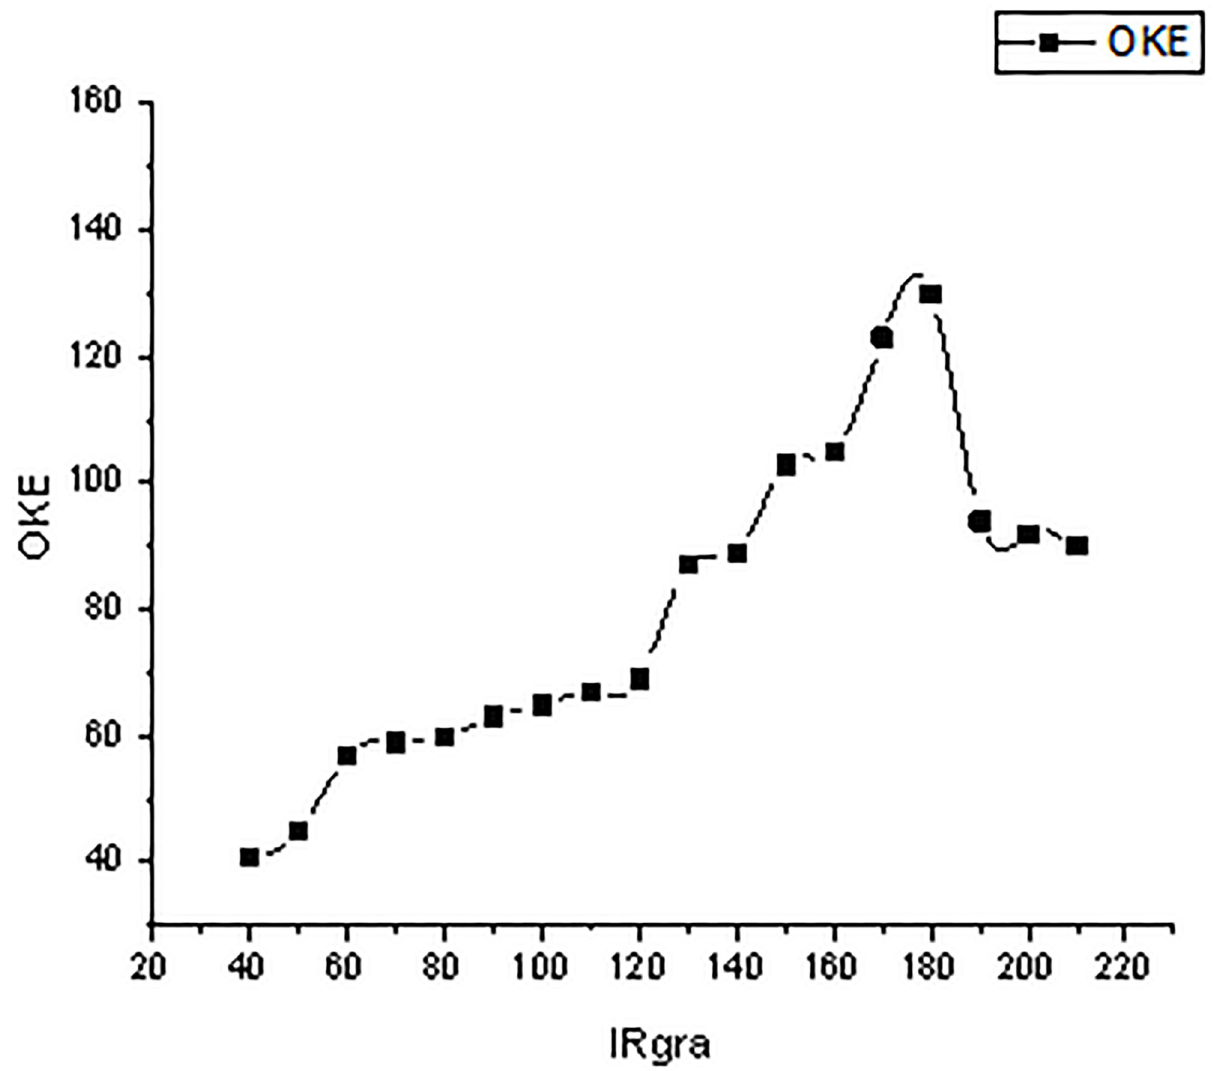
Fig 3. The old dynamic energy change whit the progressive change of manufacturing enterprises in the first stage.